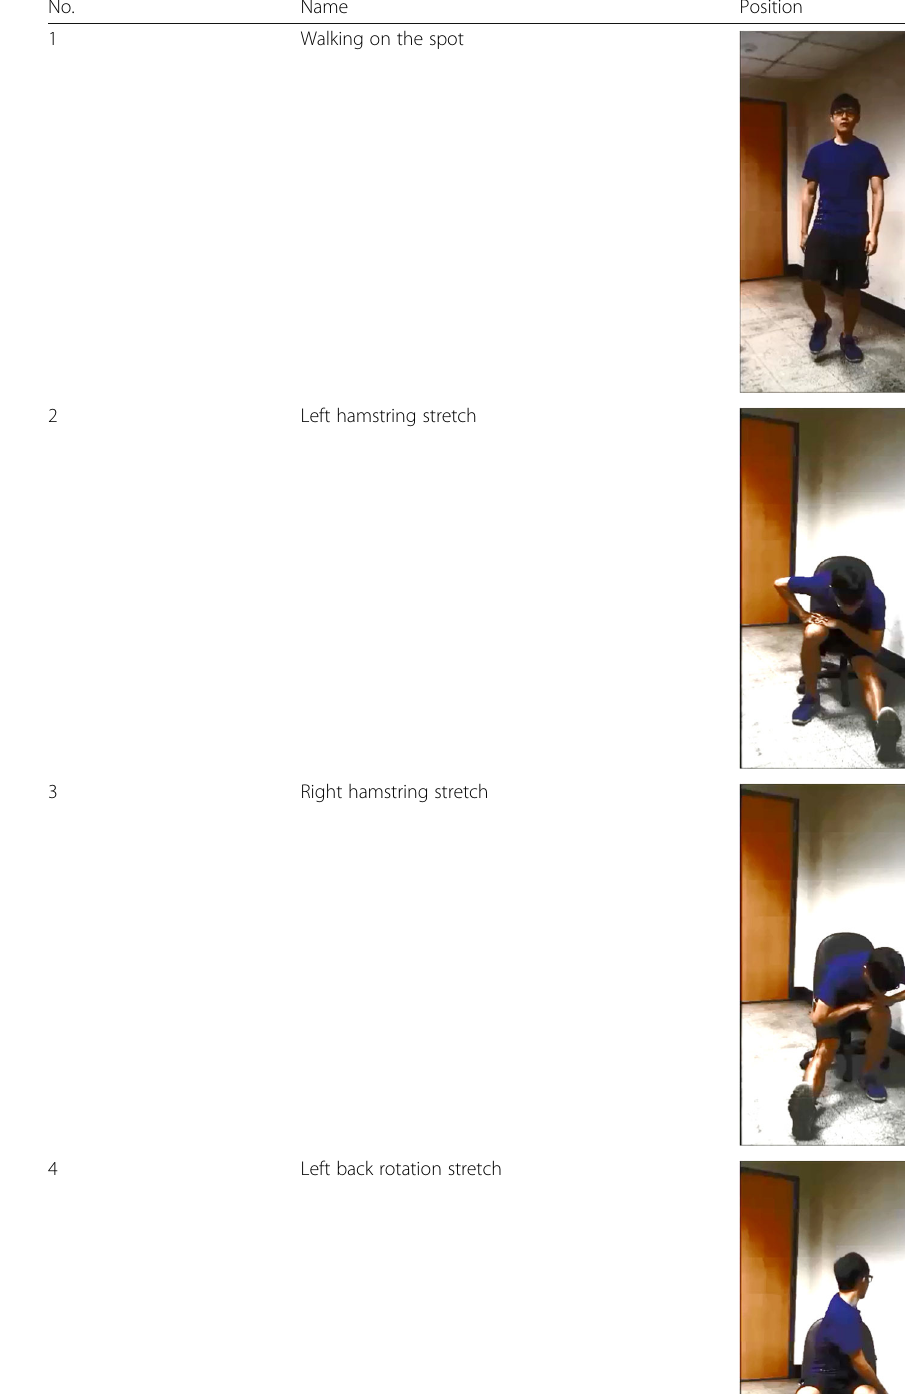
Table 4 Seven positions of the cooldown exercise